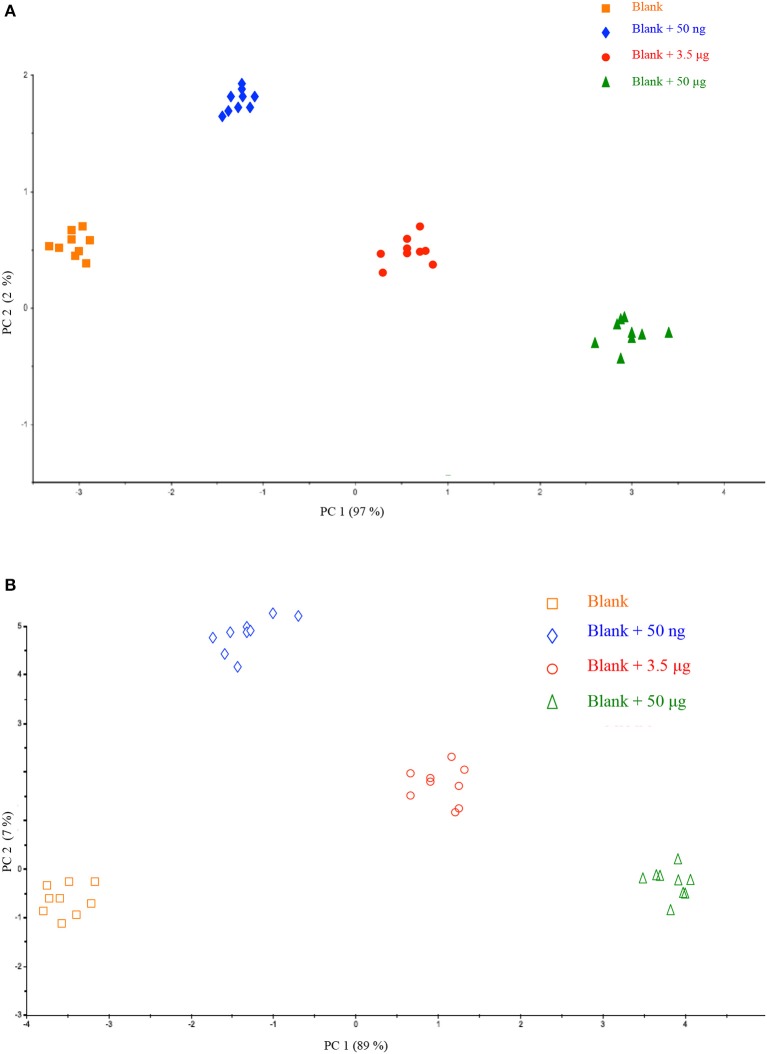
Scores plot of the Principal Component Analysis performed on the dataset related to calibration on different filters (A) and calibration on a single filter (B).